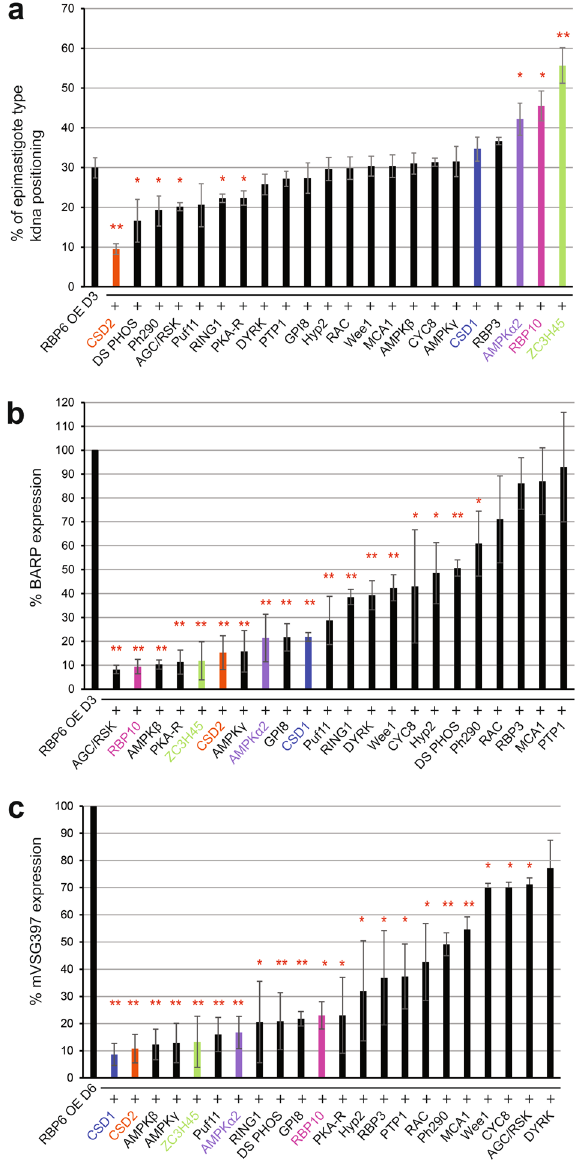
Figure 3. The targeted RNAi screen identified 22 genes that positively or negatively regulate a distinct step of metacyclogenesis. ( a ) After 3 days of doxycycline induction, epimastigotes were scored if the kinetoplast localized anterior to the nucleus in the positive control, the wild-type RBP6 overexpression cell line, and RNAi cell lines. ( b ) Three days post-induction, BARP expression was quantified using Western blot against BARP and compared to the positive control. ( c) mVSG397 expression was quantified six days post-induction by Western blot against mVSG397. The positive control expression of BARP and mVSG397 is set to 100% and the expression of BARP and mVSG397 in each RNAi cell line is a percentage ratio of the positive control. Three independent replicates were performed with means ± standard deviation (std). The P value was calculated from a two-tailed student’s t-test. *Denotes P values from 0.05 to 0.01, while **Denotes P values < 0.01. RNAi cell lines that were used for downstream RNA-Seq analysis are color